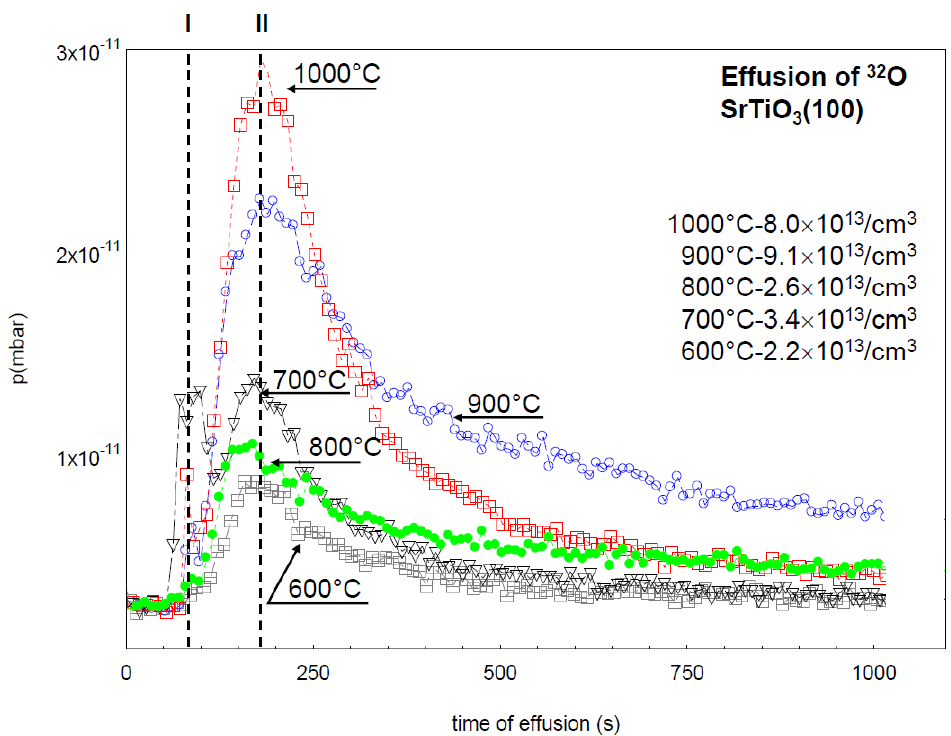
Figure 44. Measurement of the thermo-stimulated desorption of oxygen (obtained using mass spectrometry) during successive reduction of SrTiO 3 crystal under UHV conditions (T = 600–1000 °C) shows that the total concentration of the oxygen molecules, which have left the crystal is smaller than 10 15 /cm 3 . Notice: the apparatus was calibrated using controlled pump out under isobaric conditions (p const. = 10 − 6 mbar) of the vessel with exactly defined concentration of oxygen particles. The calibration procedure was the same as has been used for effusion measurement in our previous paper [45].